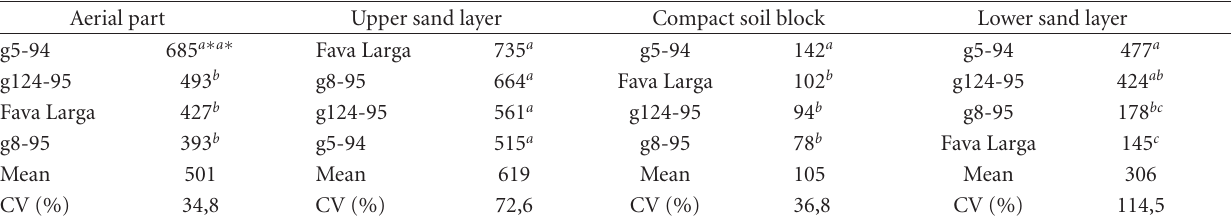
Table 2: Dry matter weights of the aerial part of the plants and of roots in the upper and lower sand layers and in the compact soil layer of experiment